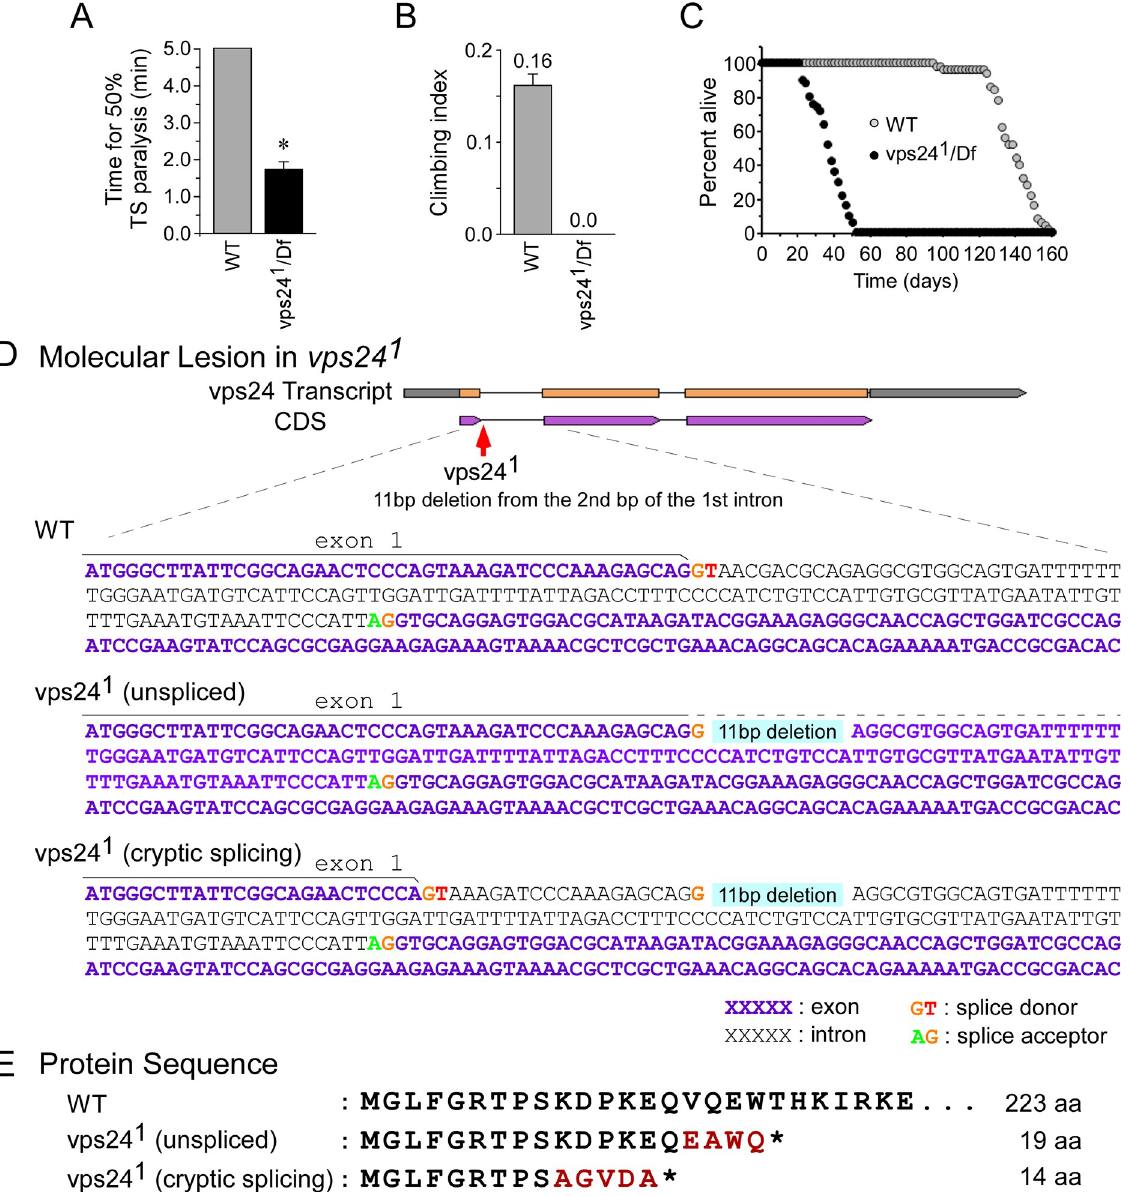
Fig 1. A new mutant of vps24 , vps24 1 . (A-C) The vps24 mutant exhibits locomotor and lifespan deficits. (A) vps24 1 /Df(3R)Exel6140 flies (vps24 1 /Df) exhibited rapid temperature sensitive (TS) paralysis at 38˚C, whereas wild-type flies (WT) did not. Tests were truncated at 5 min if 50% TS paralysis had not occurred. (B) Climbing tests, carried out at a room temperature (RT) of 22–24˚C, indicated no detectable climbing ability in the vps24 mutant. The climbing tests were truncated at 2 min if 50% climbing had not occurred and zero was given for the climbing index (see Materials and Methods). (C) Loss of the VPS24 function reduced lifespan with respect to WT. 7d old female flies raised at 20˚C were examined in these and the following behavioral studies. Here and in subsequent figures, data points represent the mean ± SEM and asterisks mark significant differences from control values ( P = 0.05). (D, E) vps24 1 mutation. (D) In vps24 1 , an 11 bp deletion occurs at the beginning of the 1st intron and removes its splice donor signal. This disrupts splicing of the 1st intron in two ways: complete failure of splicing to remove the first intron (unspliced) or use of a cryptic splice donor site contained within the WT Exon 1 (see text). The broken line above the vps24 1 (unspliced) sequence represents continuation of Exon 1. (E) Each type of aberrant vps24 transcript (unspliced or cryptically spliced) encodes a drastically truncated polypeptide composed of the first 15 or 9 amino acids of VPS24 (full length is 223) followed by several amino acids of non-VPS24 protein sequence (in red). � , stop codon.